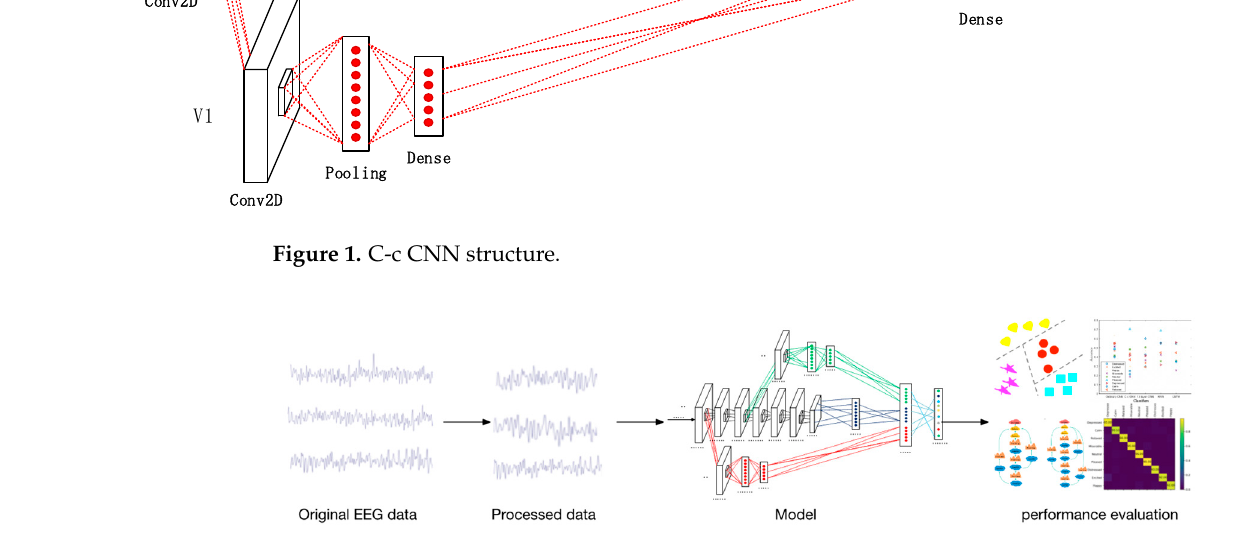
Figure 2. Schematic of the experimental process.